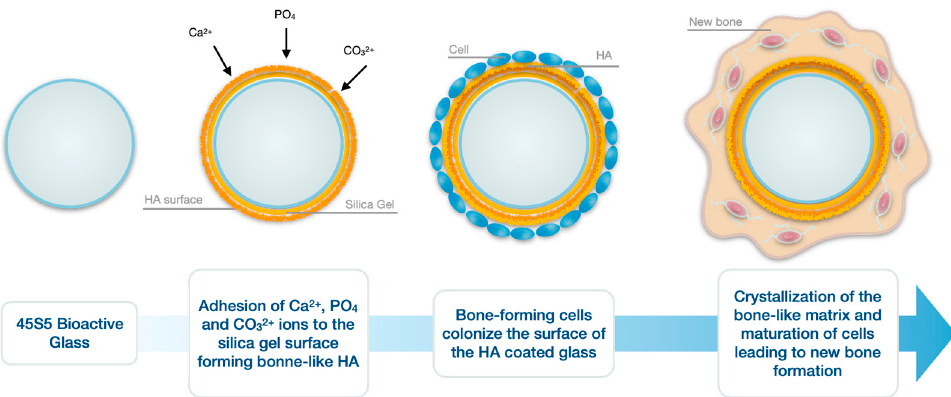
Figure 3. Biological reaction following the insertion of a bioglass into a bone defect. The reaction with physiological fluid is illustrated in the first two steps. The formation of new bone is illustrated in the last two steps. HA: hydroxyapatite. in the last two steps. HA: